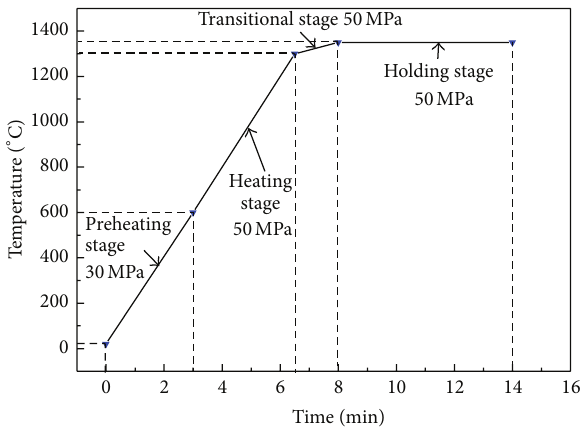
Figure 1: Schematic representation of the temperature and pressure varied with the heating time during SPS.